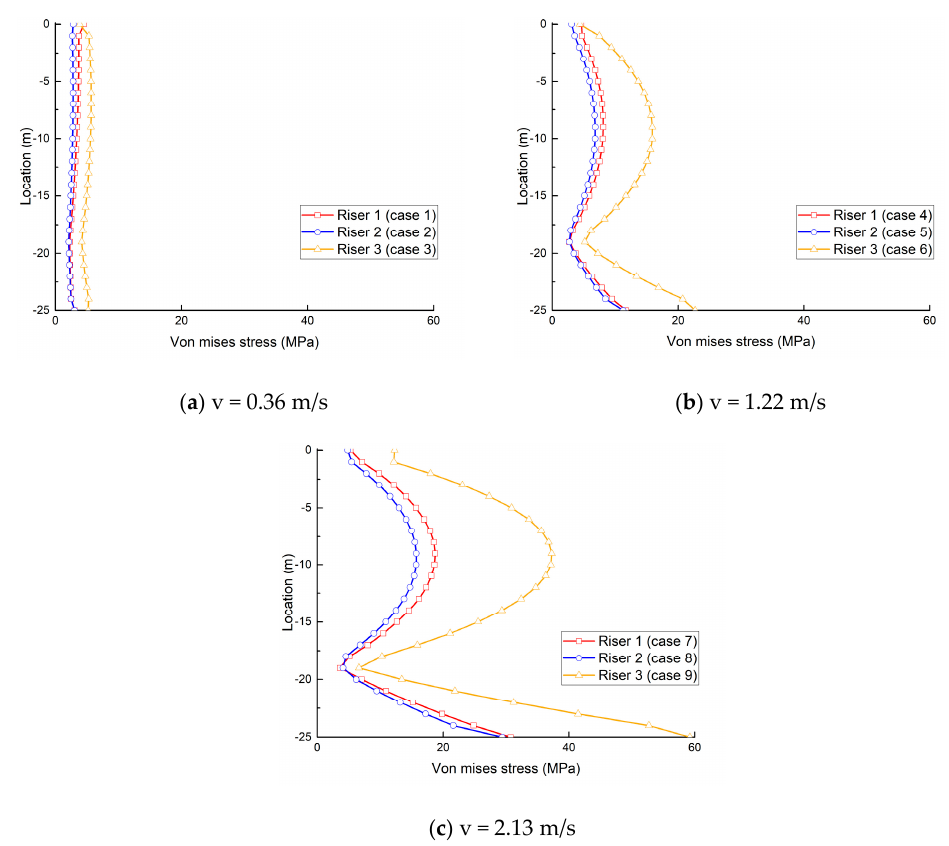
Figure 11. Maximum von Mises stresses of all three